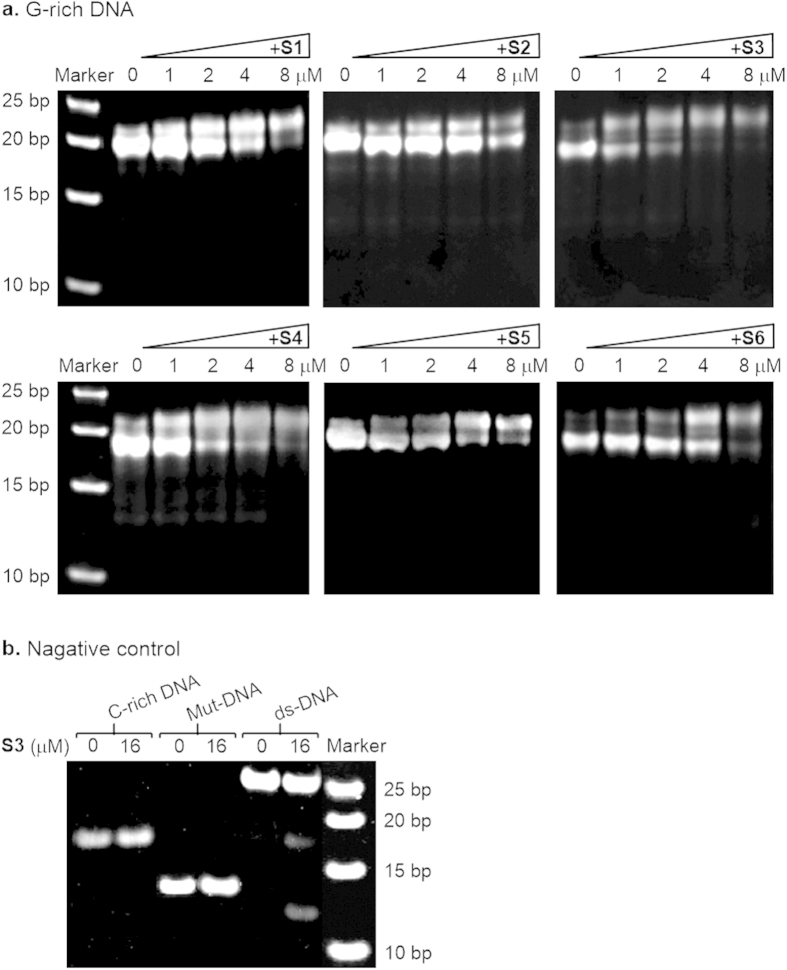
The ability of six benzothioxanthene derivatives to promote the formation of G-quadruplex structure in 26 nt telomeric DNA sequences.(a) EMSA images of Tel26nt-G-rich DNA in the presence and absence of S1–S6 at the concentration of 0, 2, 4 and 8 μM, increasing from left to right. (b) Negative control. Tel26nt-C-rich DNA, Tel26nt-double-stranded DNA and Tel26nt-mutated-strand DNA were used as a negative control and the S3 concentration was 0 and 16 μM. All experiments were performed in a buffer (pH 7.4) containing 10 mM Tris–HCl, 10 mM KCl, 0.1 mM EDTA, and samples of 2 μM DNA dissolved in the buffer in the presence and absence of compounds were incubated for 24 h after annealing at 95 °C. The reaction mixtures were resolved by electrophoresis (20% native polyacrylamide gel, 150 V, 4 h) and visualized by means of SYBR GOLD staining. Base pairs for used Marker are marked on the left side (a) and on the right side (b). Pre-preparation for all samples were shown in Methods section.